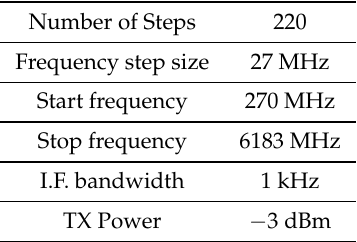
Figure 6. Antenna impedance of the loaded bowtie antenna. Table 2. Summary of the key VNA parameters